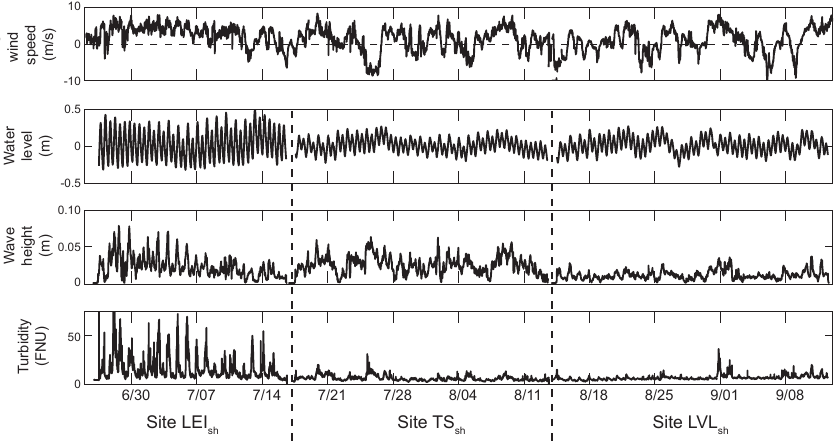
Figure 3. Time series of north–south winds (positive winds from the south), water level, significant wave height at shoal sites, and turbidity for each site, starting from the south on the